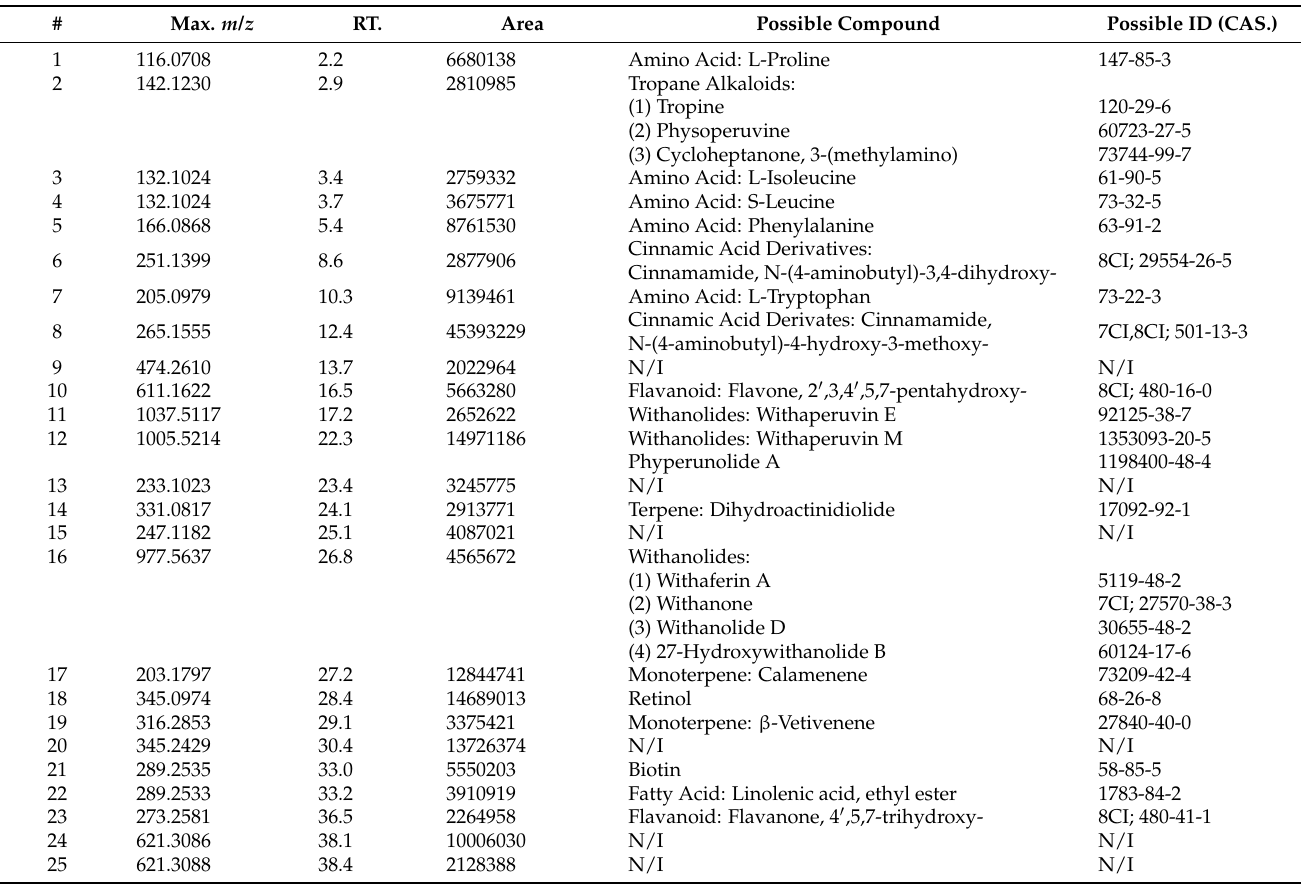
Table 1. Compounds identified in BFPP by the dereplication method.